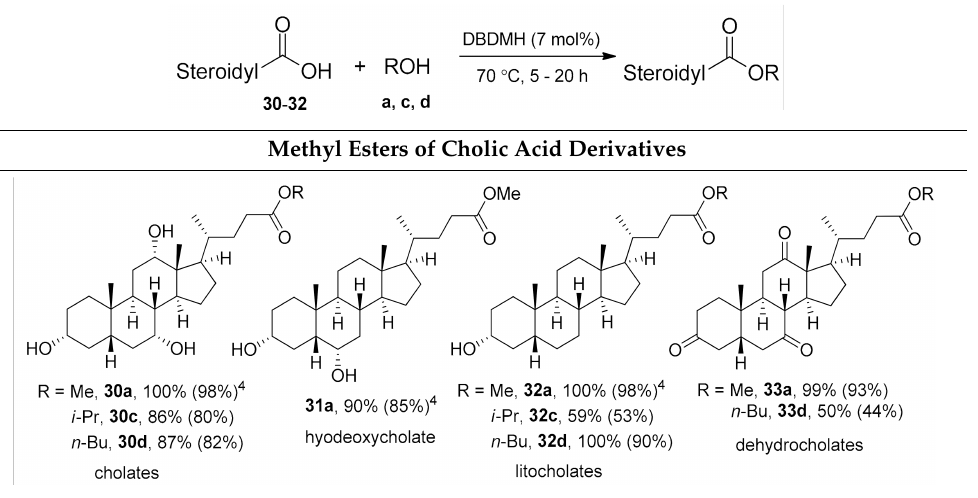
Table 6. Esterification of bile acids 1,2,3